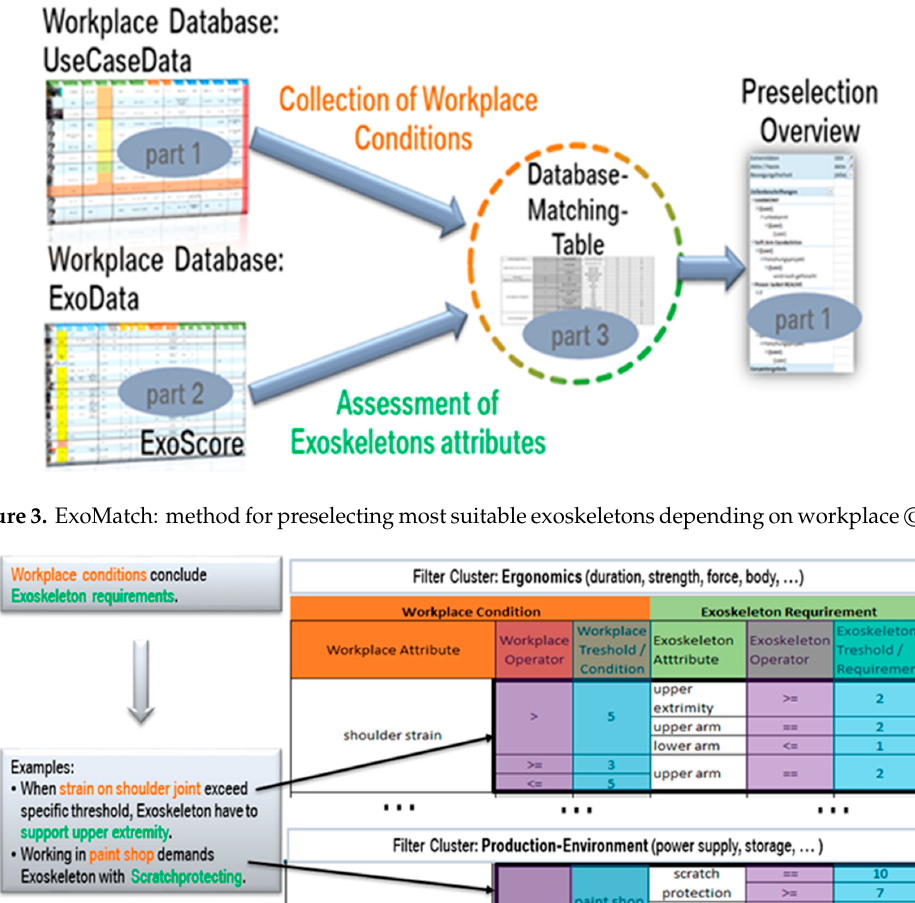
Figure 3. ExoMatch: method for preselecting most suitable exoskeletons depending on workplace © [1].